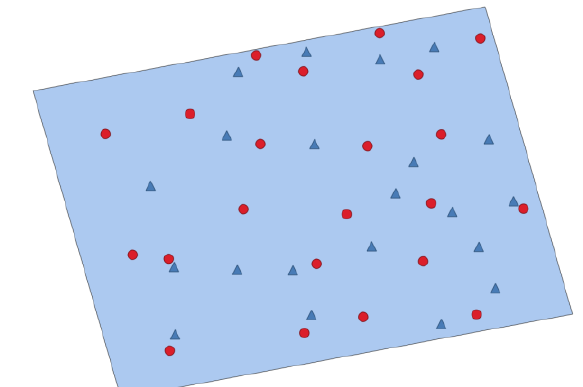
Figure 3. GCP distribution of South Korea, Seoul.